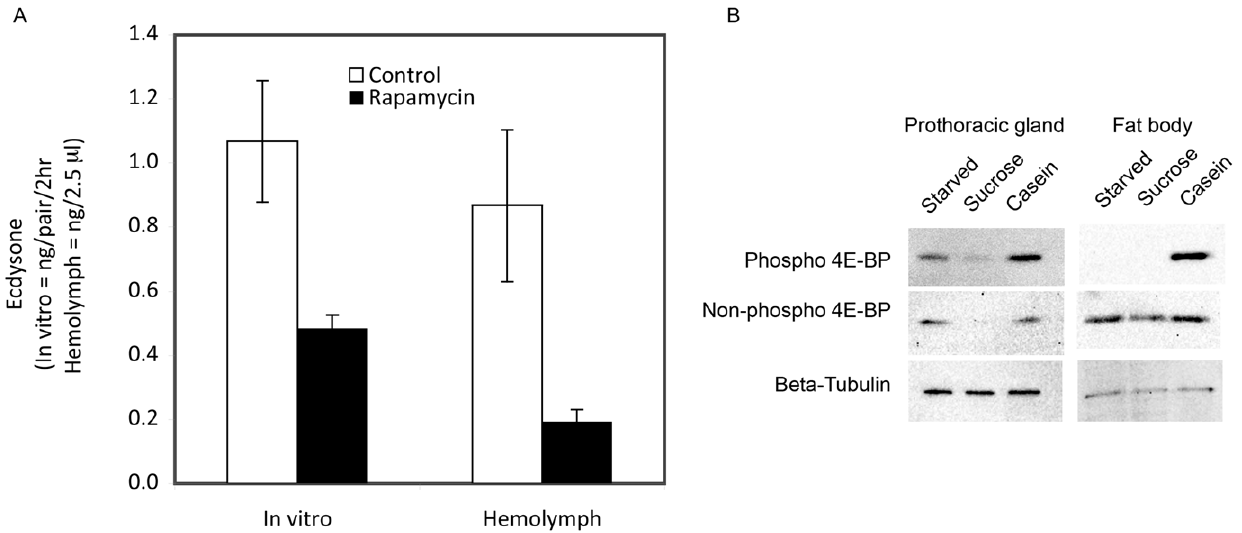
Figure 6. Effects of rapamycin and nutrients on ecdysone levels and 4E-BP phosphorylation states, respectively. (A) Effects of rapamycin treatment on ecdysone levels. Prothoracic glands and hemolymph from larvae fed 0.1 mg/ml rapamycin- or control DMSO-treated diets were isolated at average weights of 0.59 6 0.04 g and 0.61 6 0.02 g, respectively (Student’s t-test, p =0.70, n=8 larvae per group). Significant differences were observed between control and rapamyin-fed groups in hemolymph ecdysteroid levels, and in ecdysone secretion by isolated prothoracic glands (Student’s t-test, p =0.014 and 0.009, respectively). Error bars indicate standard error for ecdysone secretion. (B) Effect of nutrients on 4E-BP phosphorylation states in the prothoracic glands and the fat body. In both the prothoracic glands and the fat body, the presence of amino acids led to elevated phosphorylated 4E-BP levels relative to sucrose fed larvae or starved larvae. In the prothoracic glands, phospho-4E-BP levels were also elevated in the starved larva relative to the sucrose fed larva.